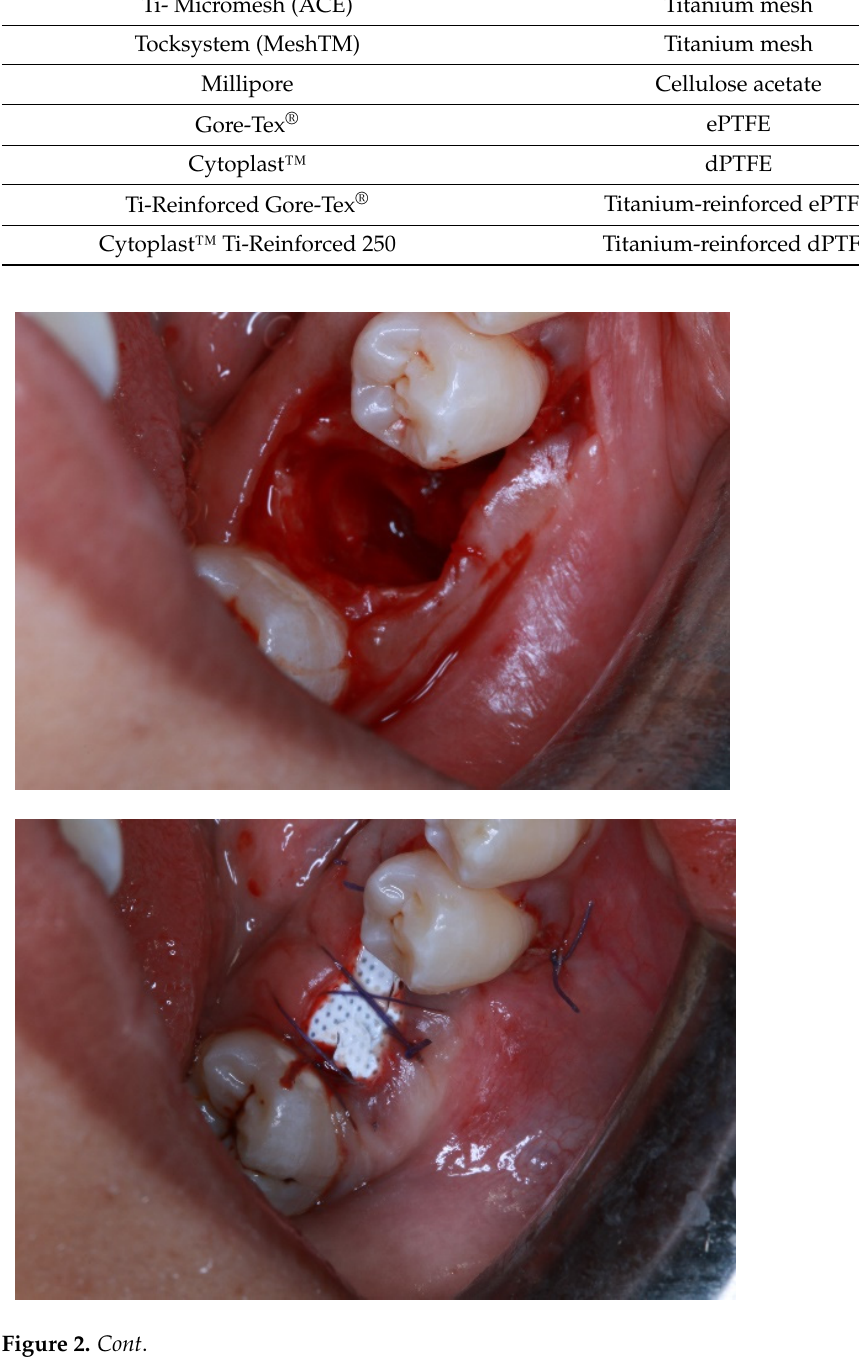
Figure 2. A schematic clinical photography series showing alveolar socket preservation performed on lower molar and utilization of dPTFE membrane secured by simple interrupted suturing tech- nique. Note that the exposure of the barrier membrane is permissible, due to small microspores in properties, preventing bacterial ingress and, thus, simplifying surgical procedure. The final photo shows review of the surgical site upon removal of dPTFE membrane a month later.